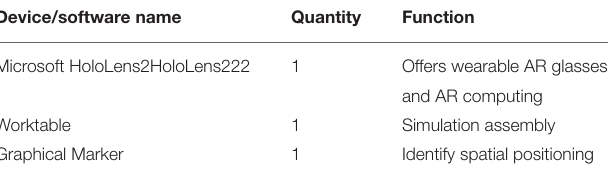
TABLE 2 | Device name list.